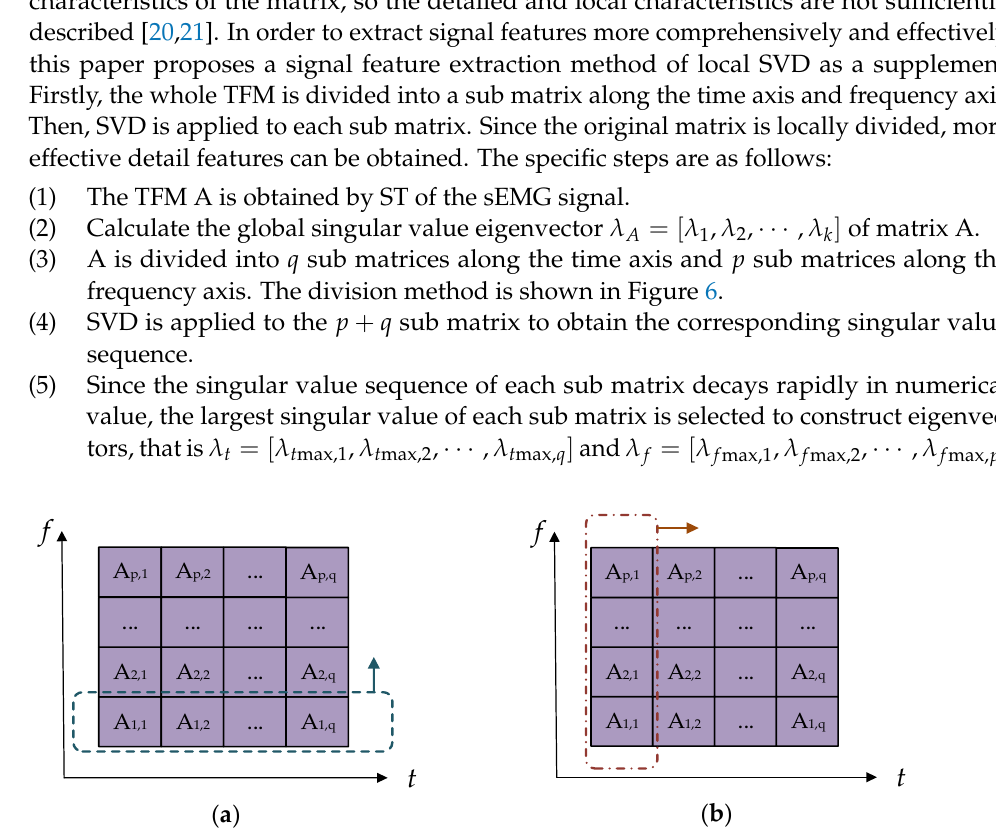
Figure 6. Schematic diagram of sub matrix division: ( a ) sub matrix divided along the frequency axis and ( b ) sub matrix divided along the time axis.